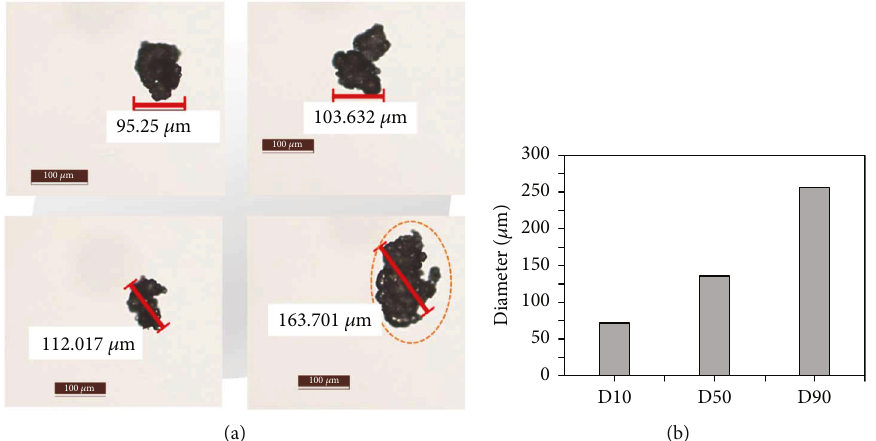
Figure 2: (a) Morphology of Dis-UHMWPE particles. (b) Mean diameters of Dis-UHMWPE particles in cumulative distribution of 10%, 50%, and 90%.